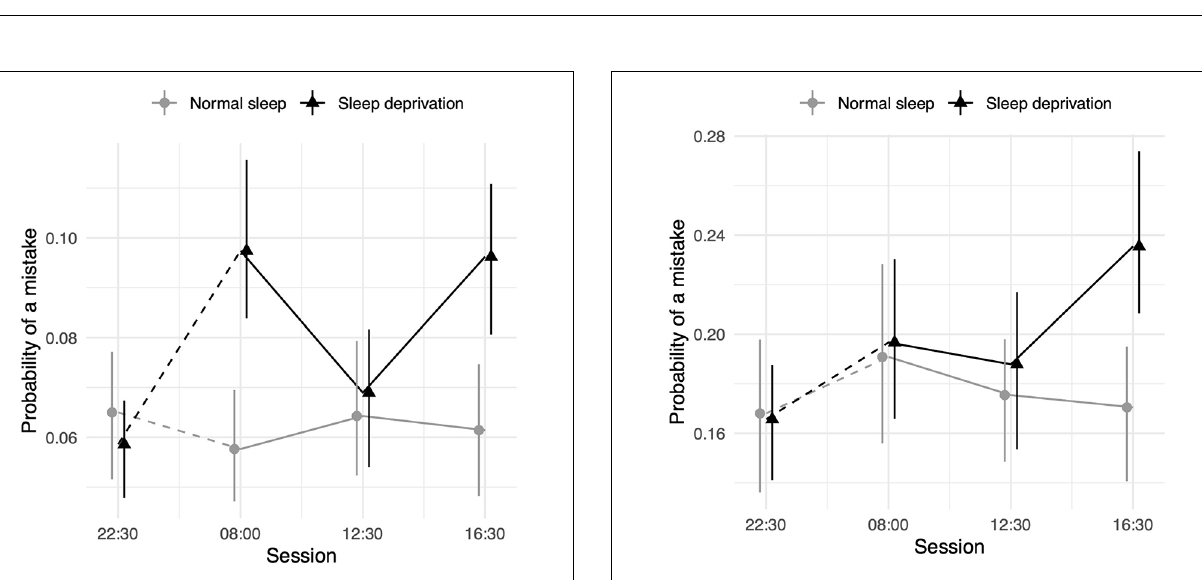
FIGURE 2 | Arithmetic test performance depending on sleep condition and time-of-day. (A) Represents performance measured by the probability of making a mistake. (B) Represents performance measured by RT (in ms). Dots represent fixed-effect estimates and error bars represent bootstrapped confidence intervals with 100 iterations. The dotted line between 22:30 h and 08:00 h represents the night of total sleep deprivation for the sleep-deprivation group.